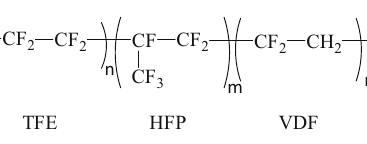
Figure 1: Monomeric units of THV. HFP, hexa fl uoroethylene; VDF, vinylidene fl uoride; TFE, tetra fl